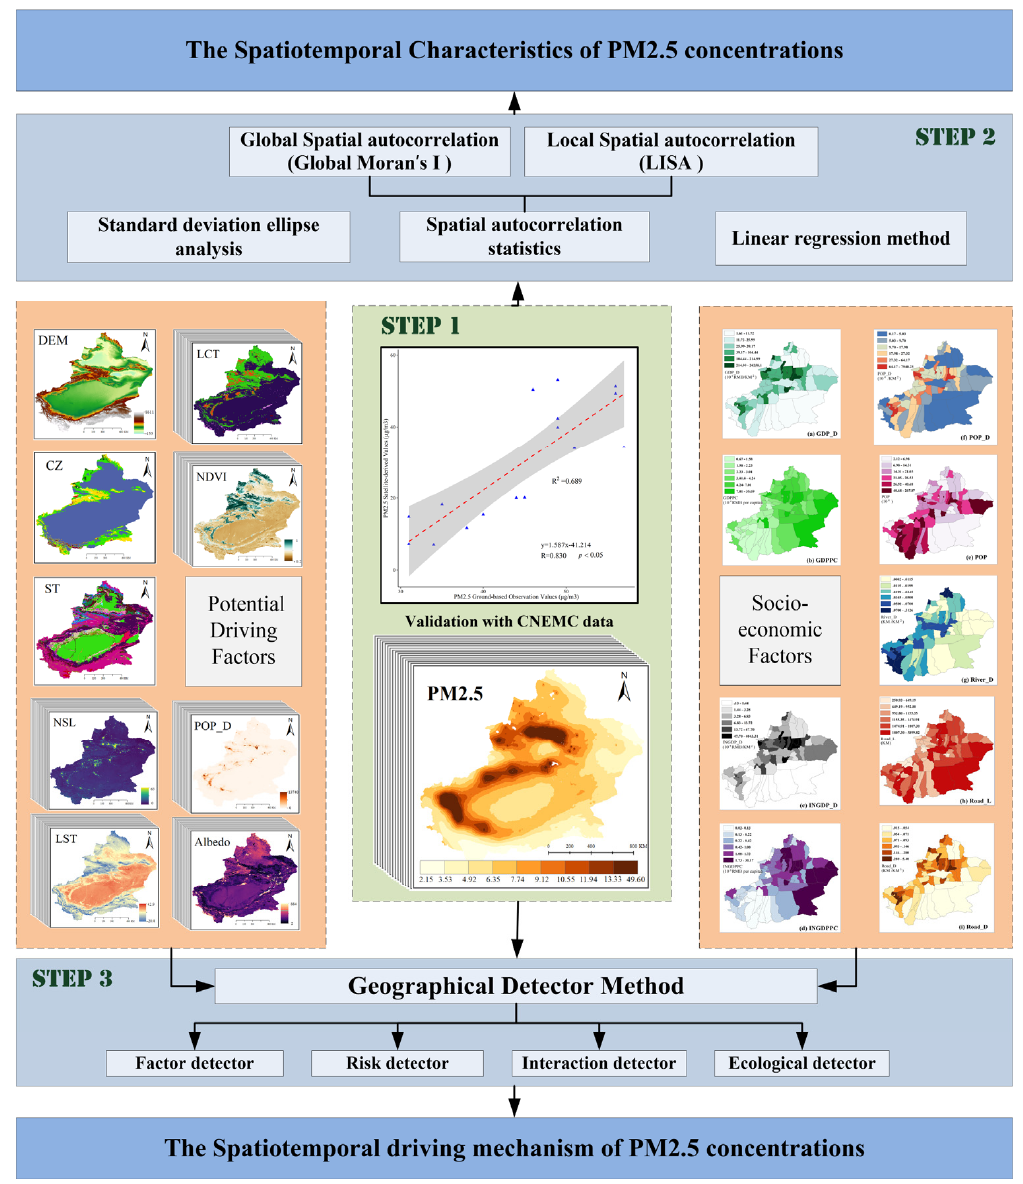
Figure 3. The technical flowchart of this study.